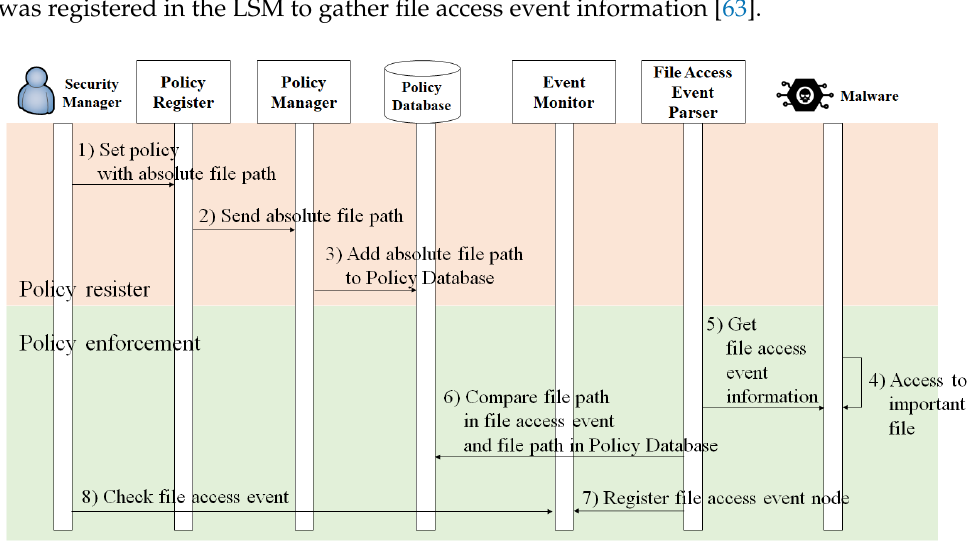
Figure 5. Real-time file access monitoring function